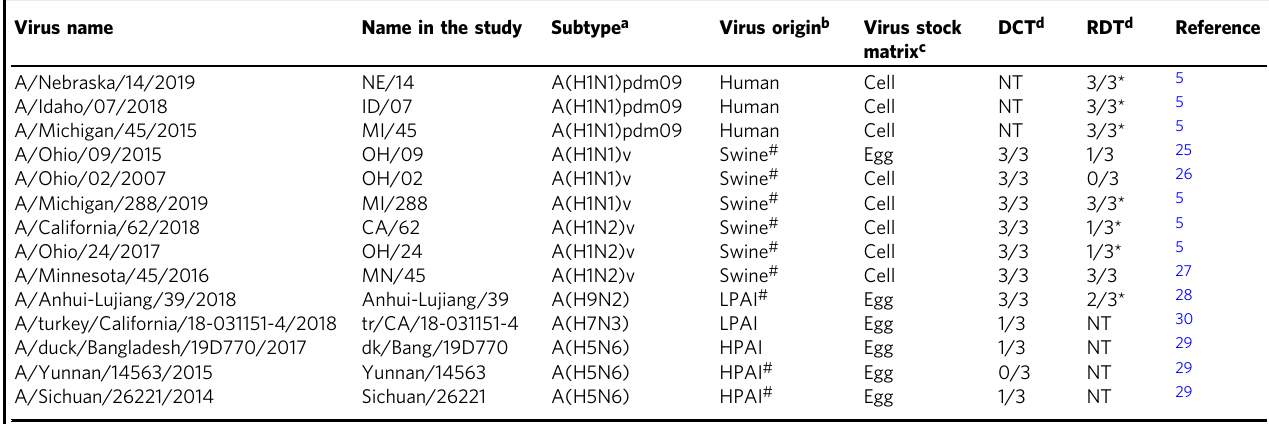
Table 1 Transmissibility pro fi les of IAVs evaluated in this